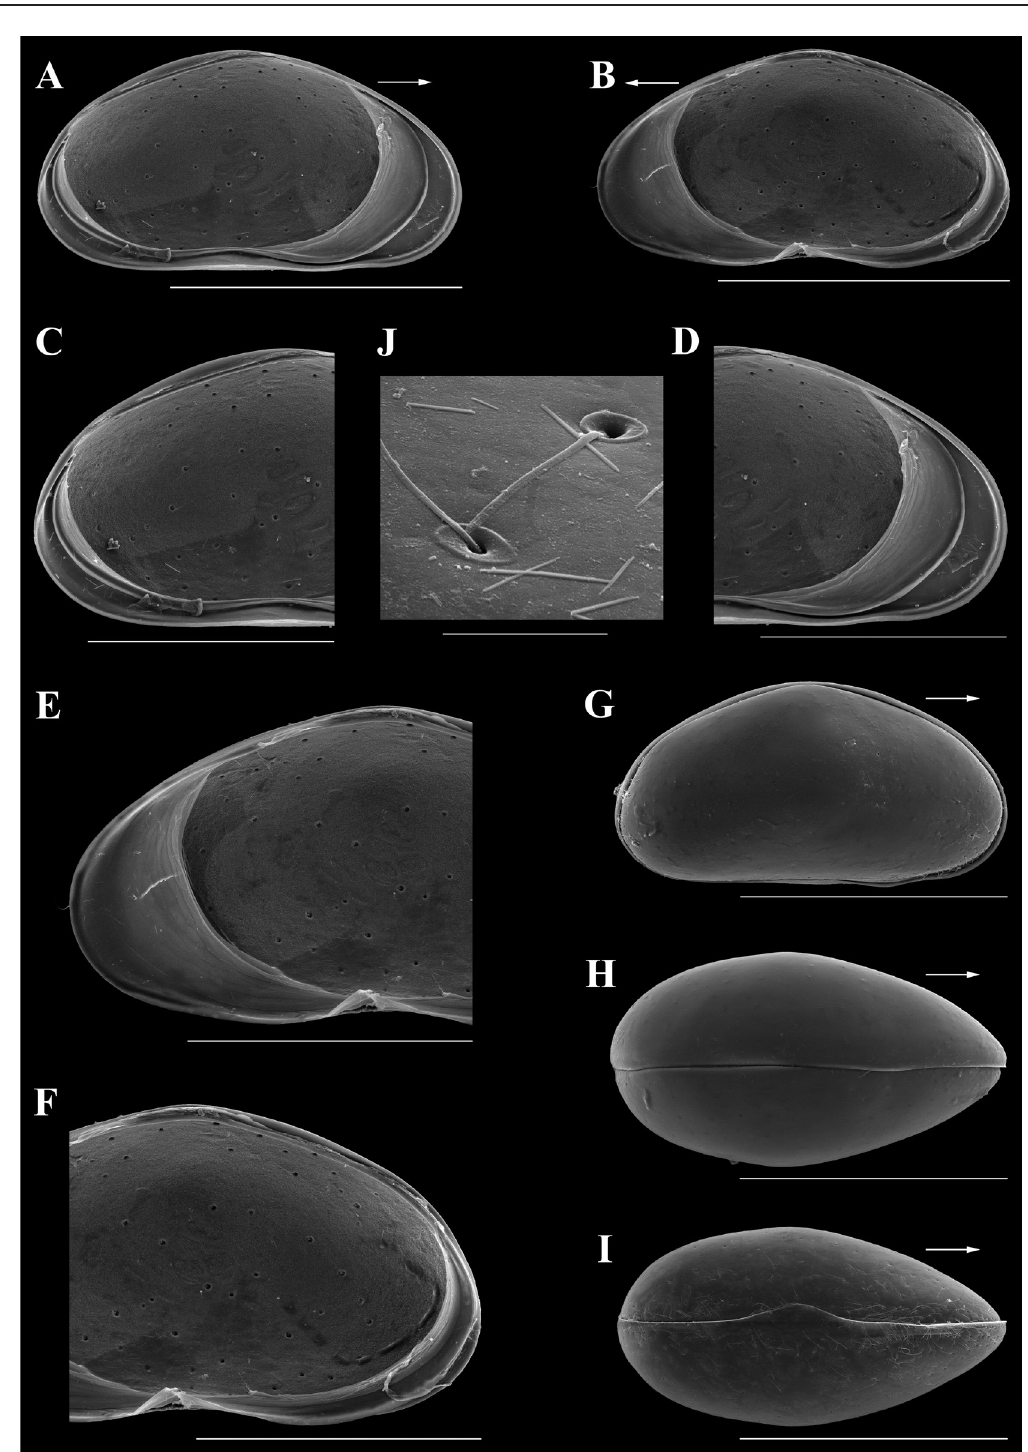
Fig. 12. Brasilodopsis baiabonita gen. et sp. nov. from Upper Paraná River floodplain, ♀. A . LVi (MZUSP 41848). B . RVi (MZUSP 41848). C . LVi, detail of posterior part (MZUSP 41848). D . LVi, detail of anterior part (MZUSP 41848). E . RVi, detail of anterior part (MZUSP 41848). F . RVi, detail of posterior part (MZUSP 41848). G . CpRl (MZUSP 41849). H . CpD (MZUSP 41850). I . CpV (MZUSP 41851). J . CpV, detail of Cp surface (MZUSP 41851). Scale bars: A–B, G–I = 300 µm; C–F = 200 µm; J = 10